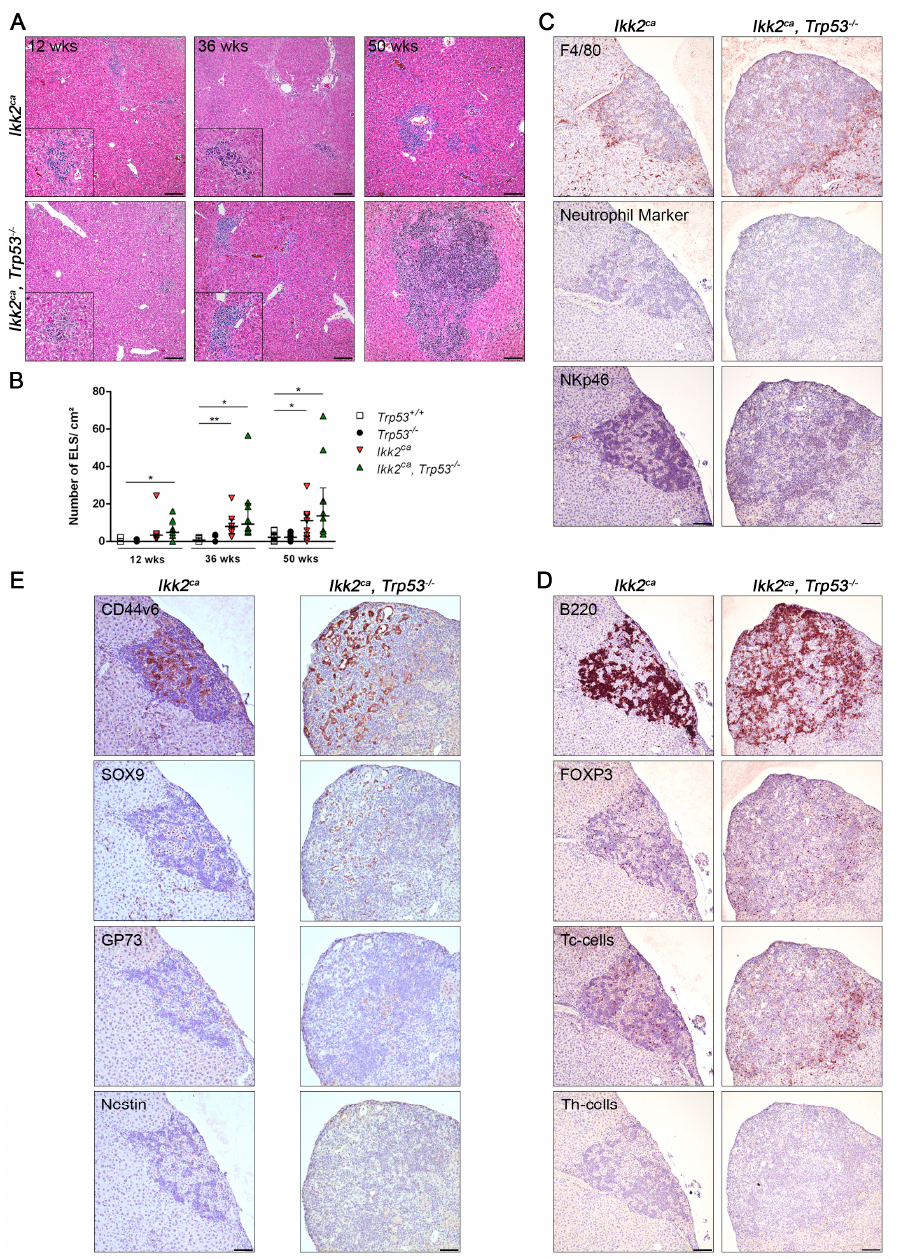
Figure 5. Formation of ectopic lymphoid structures (ELS) serves as a microniche for liver progenitor cells. ( A ) Representative photographs of H&E stained liver sections from Ikk2 ca and Ikk2 ca Trp53 − / − mice (scale bar: 100 µm). ( B ) Graph depicts the number of ELS per square centimeter in liver of Trp53 +/+ , Trp53 − / − , Ikk2 ca and Ikk2 ca Trp53 − / − mice ( n = 5–10). Data represent the median with interquartile range; * p < 0.05, ** p < 0.01. ( C , D ) Representative photographs of IHC for the innate immune system ( C ) macrophages (F4/80), neutrophils (Neutrophil Marker) and NK cells (NKp46) and the adaptive immune system ( D ) B-cells (B220), T regulatory cells (FOXP3), cytotoxic T-cells (Tc-cells) and T helper-cells (Th-cells) in ELS of Ikk2 ca and Ikk2 ca Trp53 − / − mice (scale bar: 100 µ m). ( E ) Accumulation of liver progenitor cells in ELS. Representative photographs of IHC for CD44v6, SOX9, GP73 and Nestin in ELS of Ikk2 ca and Ikk2 ca Trp53 − / − mice (scale bar: 100 µ m). The IHC are performed on consecutive sections for immune cells ( C , D ) and progenitor cell markers ( E